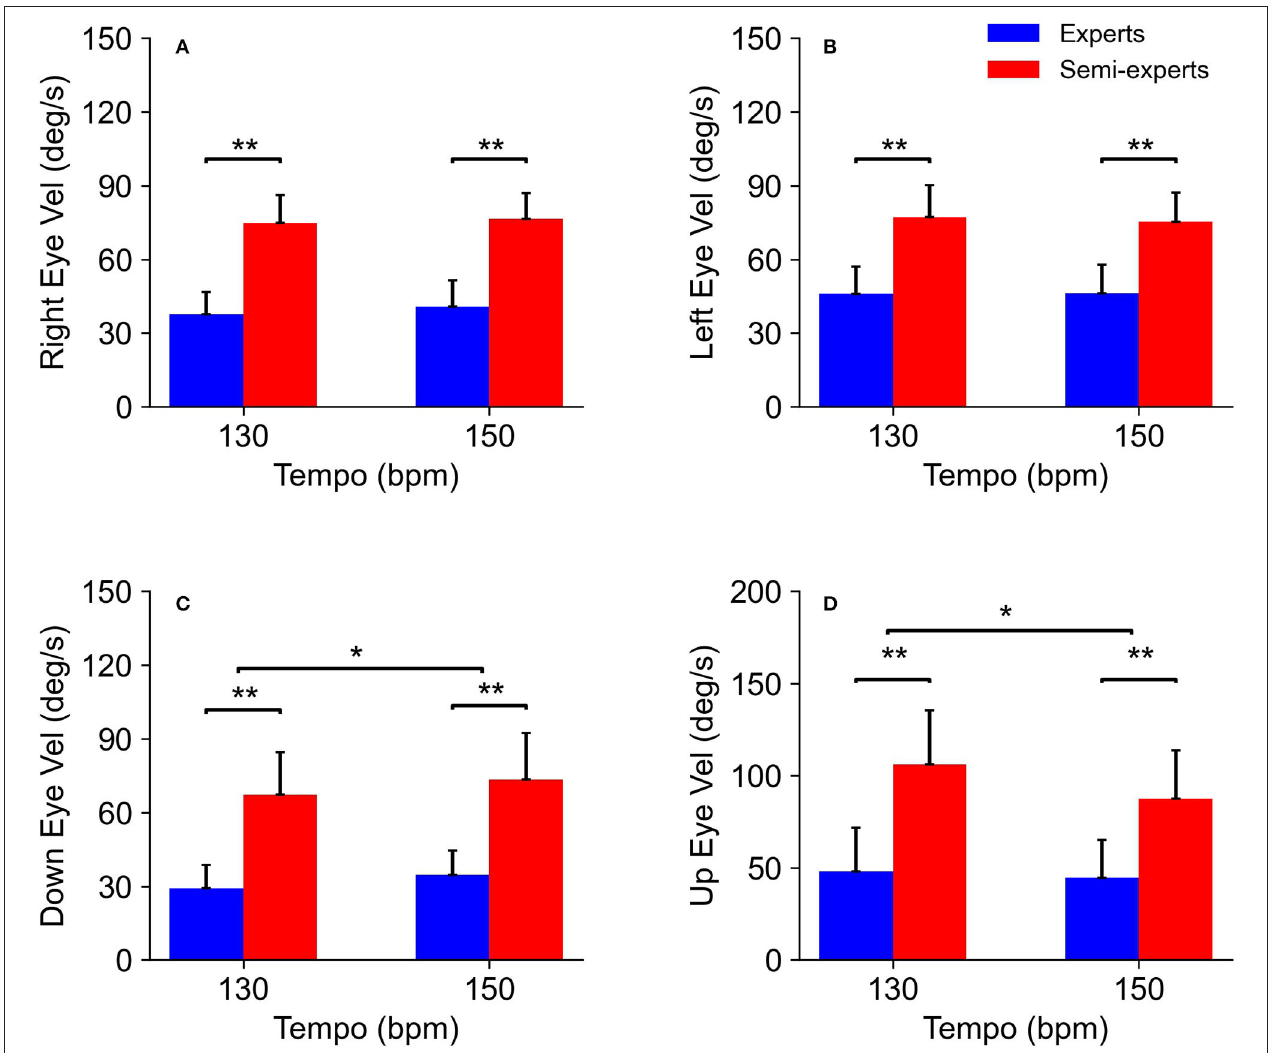
FIGURE 7 | Comparison of the eye velocity of the expert and semi-expert groups in the two tempo conditions. (A) Comparison of the rightward eye velocity (right head vel), (B) leftward eye velocity (left head vel), (C) downward eye velocity (down head vel) and, (D) upward eye velocity (up head vel) between the experts and semi-experts in the two conditions are